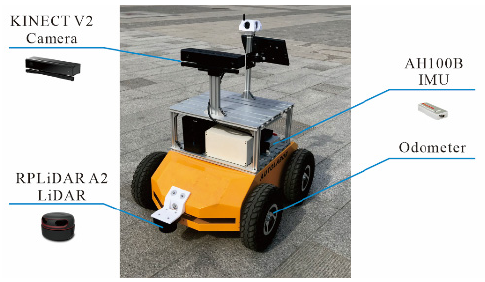
Figure 12. Robot platform and sensors.